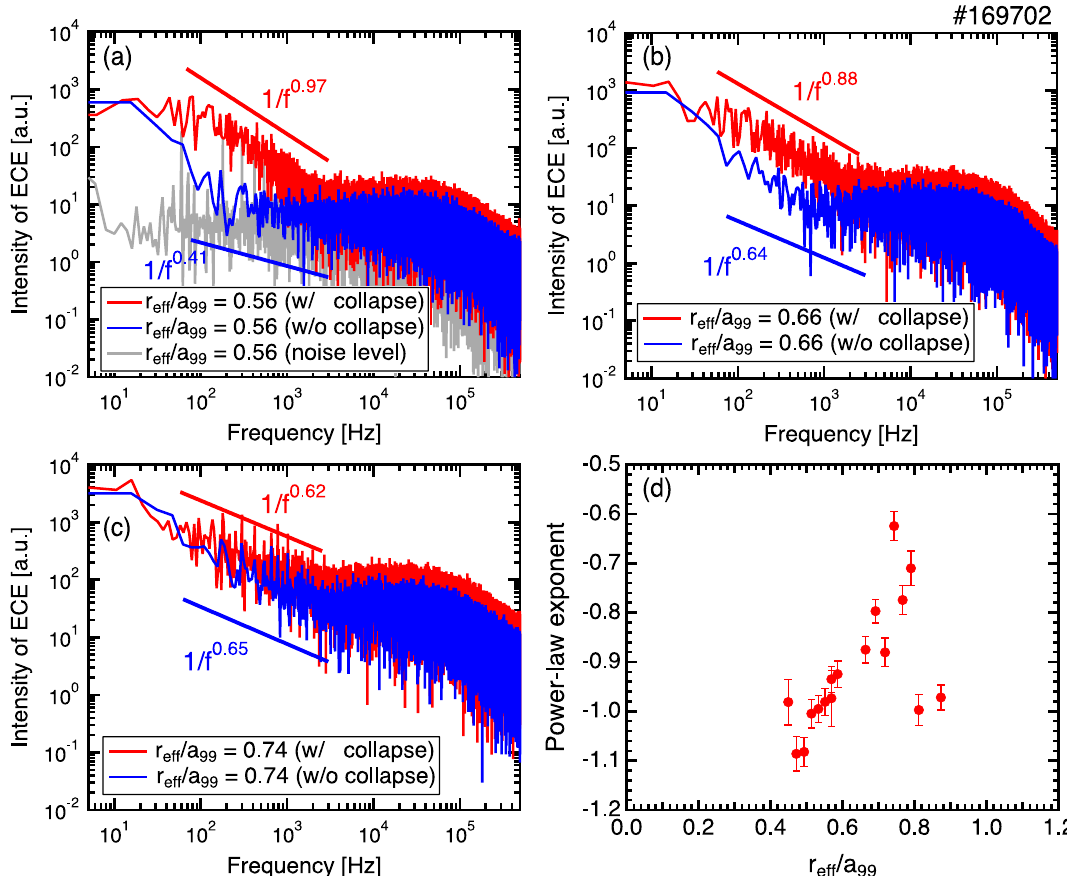
Figure 5. Frequency spectrum of the ECE signal with (red, t = 4.366 –4.527 s) and without (blue, t = 4.300 –4.366 s) the minor collapse events at r eff / a 99 = ( a ) 0.56, ( b ) 0.66, and ( c ) 0.74. ( d ) Power-law exponents